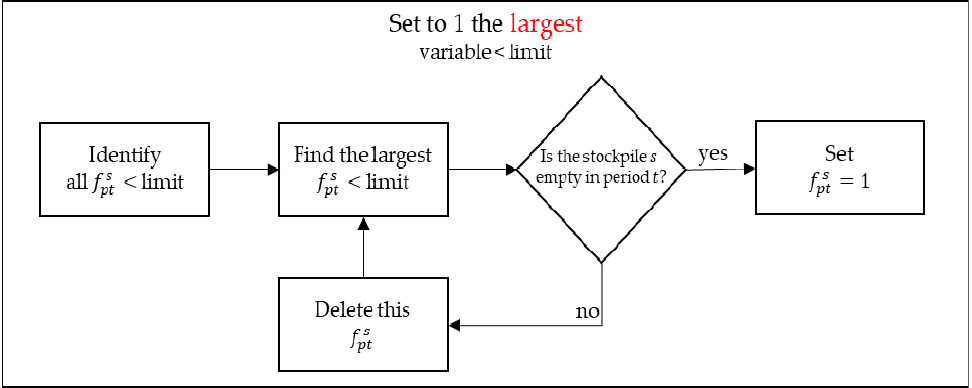
Figure 5. How to work the process of setting the largest variable.